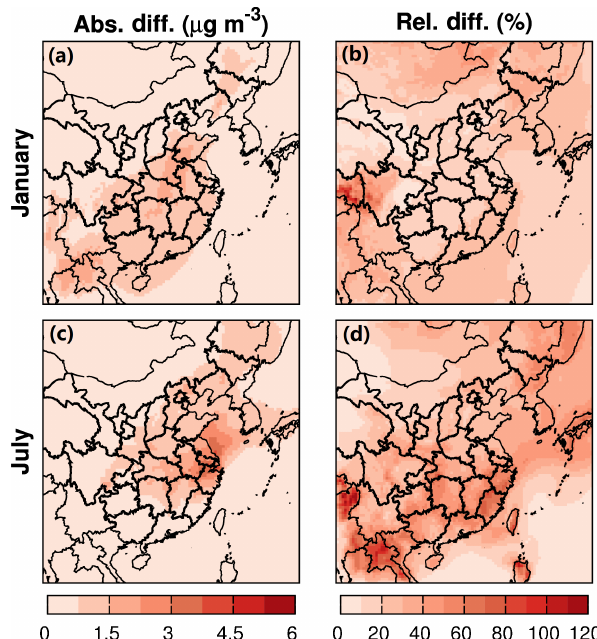
Figure 9. Monthly averaged impacts of nonideality of the organic– water mixture on SOA. “Abs. Diff.” represents absolute differ- ences (C3–C1); “Rel. Diff.” represents relative differences ((C3– C1)/C1;